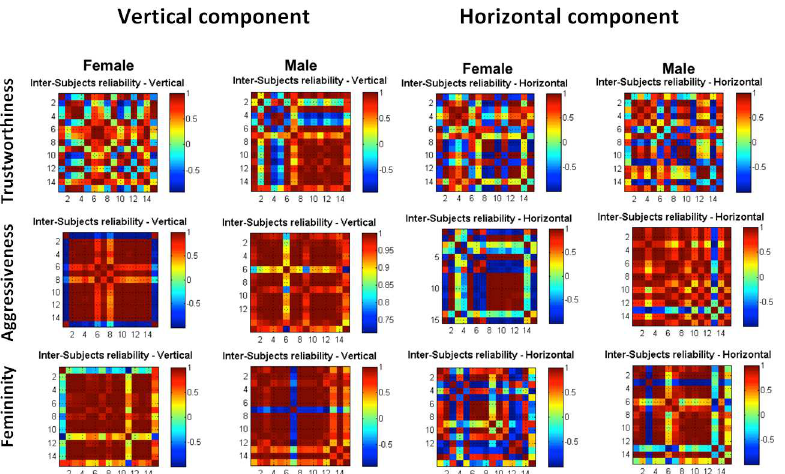
Fig 4. Inter-subject reliability. From left to right, matrixes of correlationfor female and male databaseused for the vertical and the horizontal component.From top to bottom the three social judgments performed during the experiments: trustworthiness, aggressiveness and femininity. Each graph represents a correlationmatrix across participants (n = 15 for each experiment). For each participant, ratings of the vertical component (SH, MH, BH) have been correlated to ratings obtainedfor the three categoriesof every other participant. The same analysishas been performed using scores of the horizontalcomponent(SW,MW,BW). Colors bar representthe degreeof correlationusing R from blue (negativecorrelation,-1) to red (positivecorrelation,+1). Participants reachedhigheragreement while judging faces modulated by the vertical